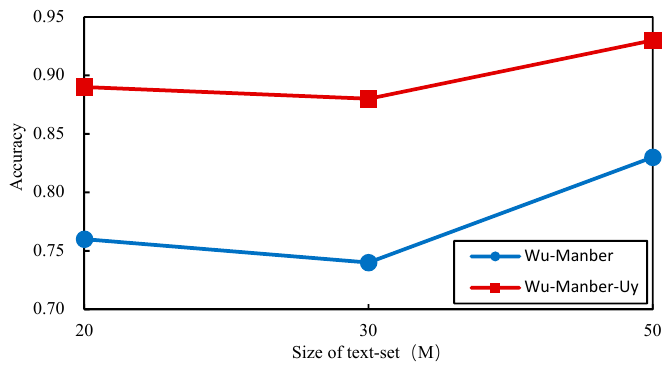
Figure 12. Comparison of matching accuracy.